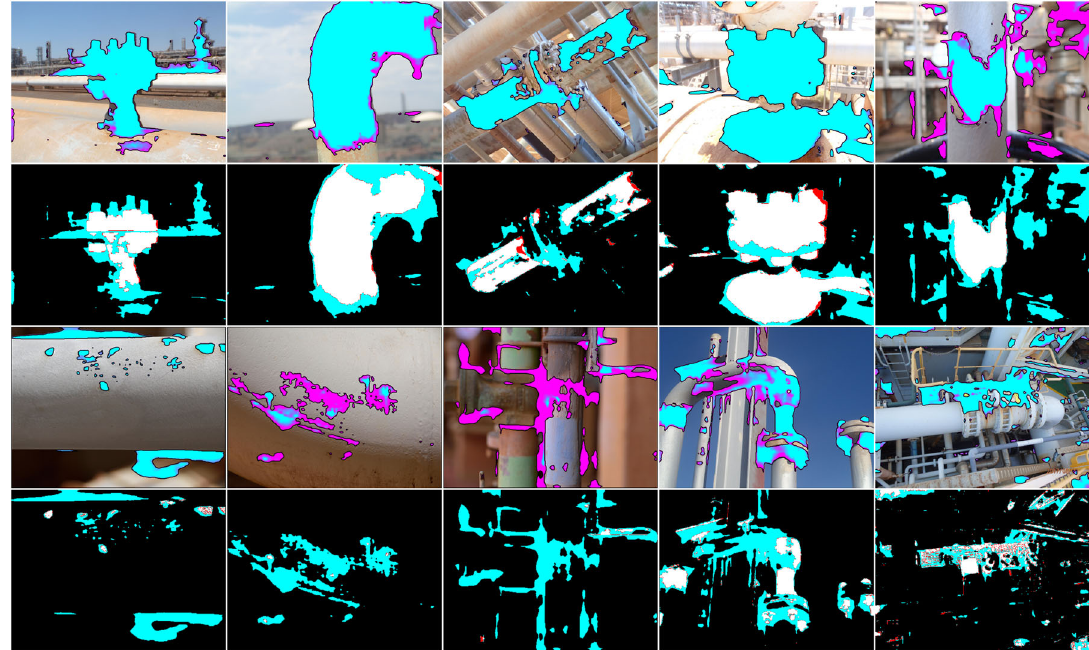
Fig. 7 Monte-Carlo dropout model detection and accuracy maps. The corrosion detection output ( fi rst and third row) and accuracy maps (second and fourth row) from the Monte-Carlo dropout model of the input and ground truth label maps shown in Fig. 5. Detection colour determined by output layer con fi dence, cyan is higher.